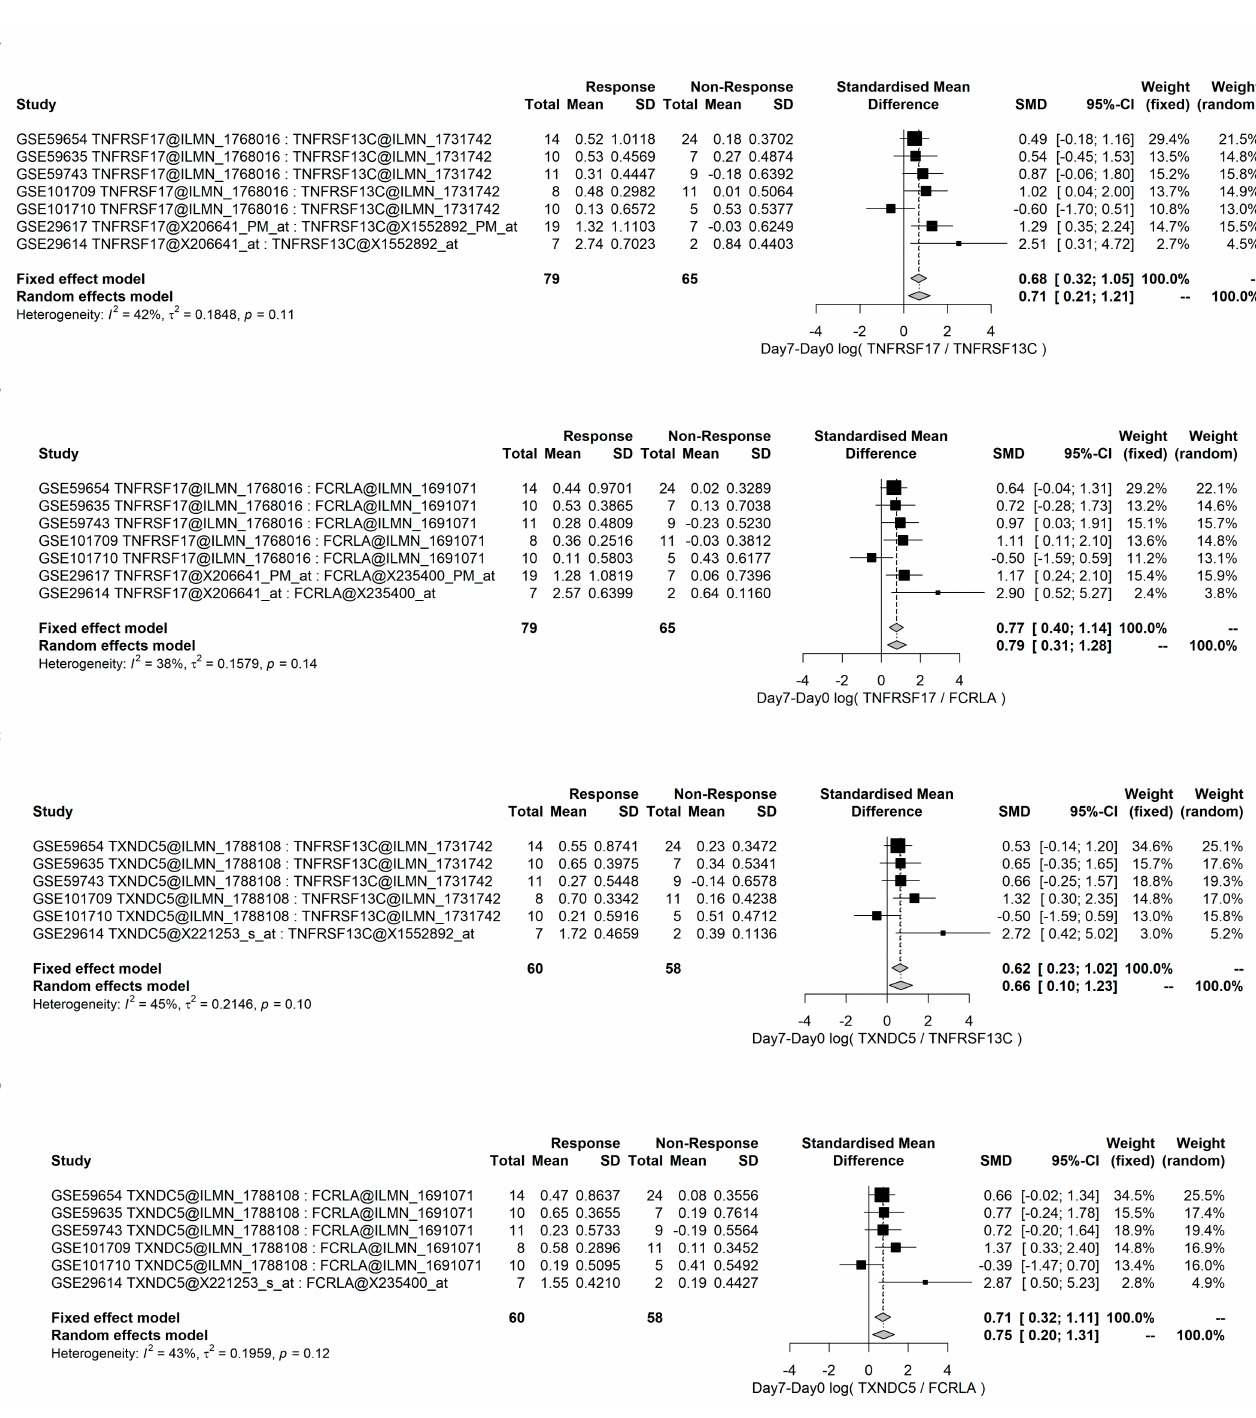
Figure 7. Meta-analysis of the differential increment from Day 0 to Day 7 of Direct B lymphocyte-LSTA between R and NR groups. ( A , B ) are the results of the differential increment of Direct LS-TA of TNFRSF17 using two different B lymphocyte reference genes (TNFRSF13C and FCRLA). ( C , D ) are the results of the differential increment of the Direct LS-TA results of TXNDC5. Direct B lymphocyte-LSTA showed significantly higher increments among the responders with an overall effect SMD of between 0.62 to 0.77. The specific probe sets used in the calculation of Direct LS-TA are also shown in the table following the gene